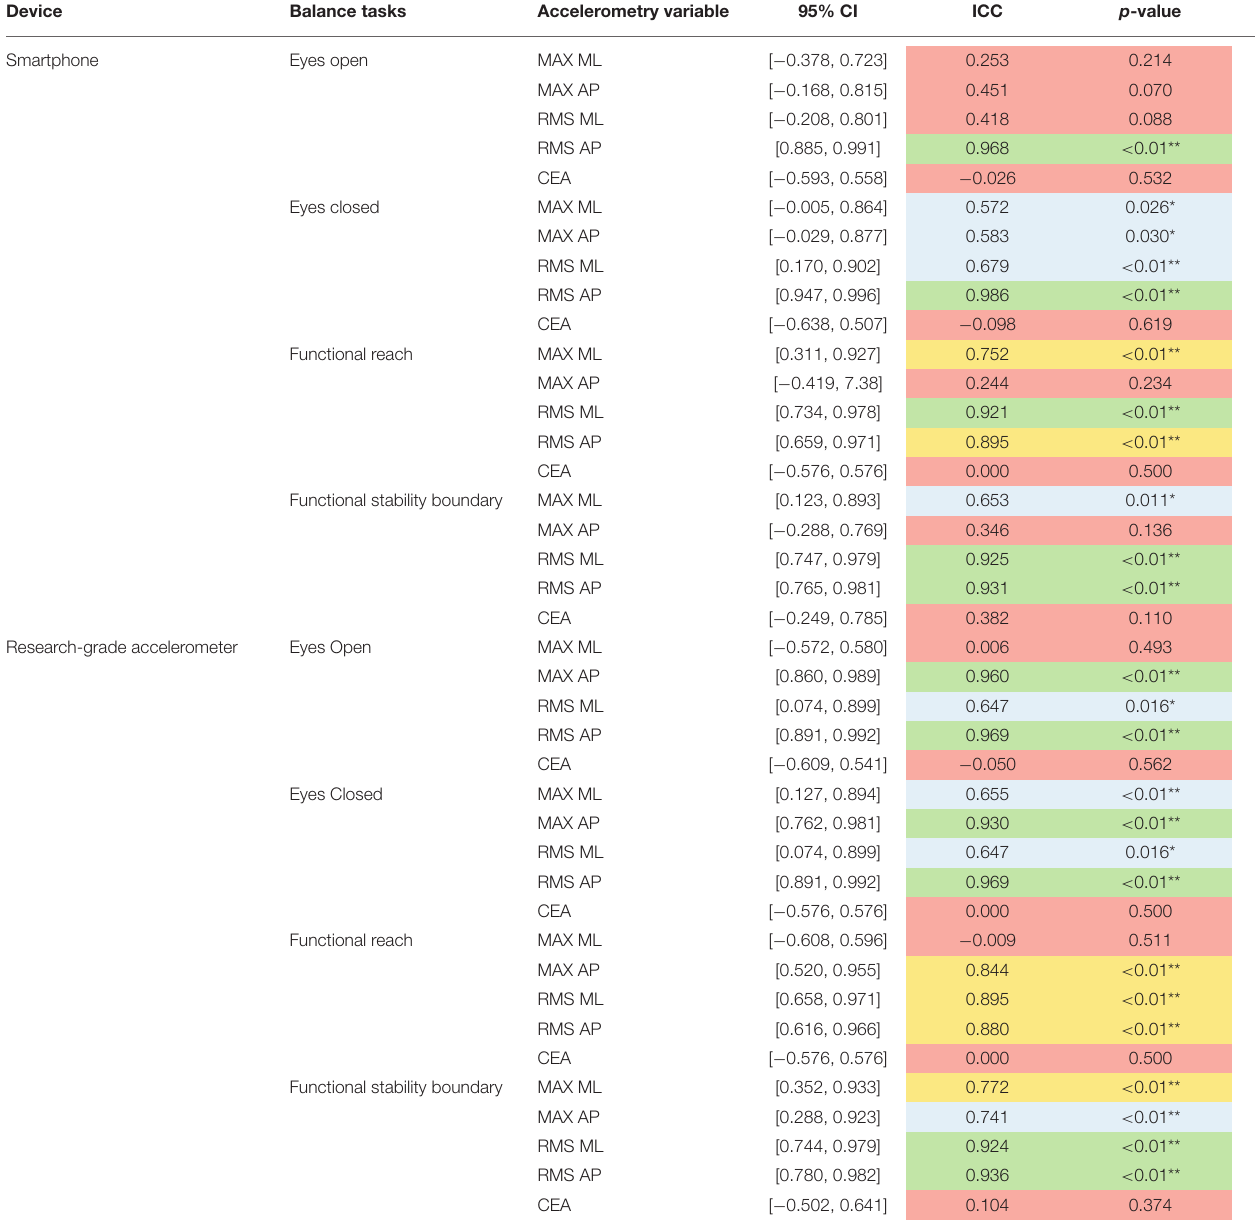
TABLE 4 | Interclass correlations (ICC) between maximum (MAX) acceleration, root mean squared (RMS) acceleration, and confidence ellipse area (CEA) as recorded through smartphone and research-grade accelerometry during session 1 and session